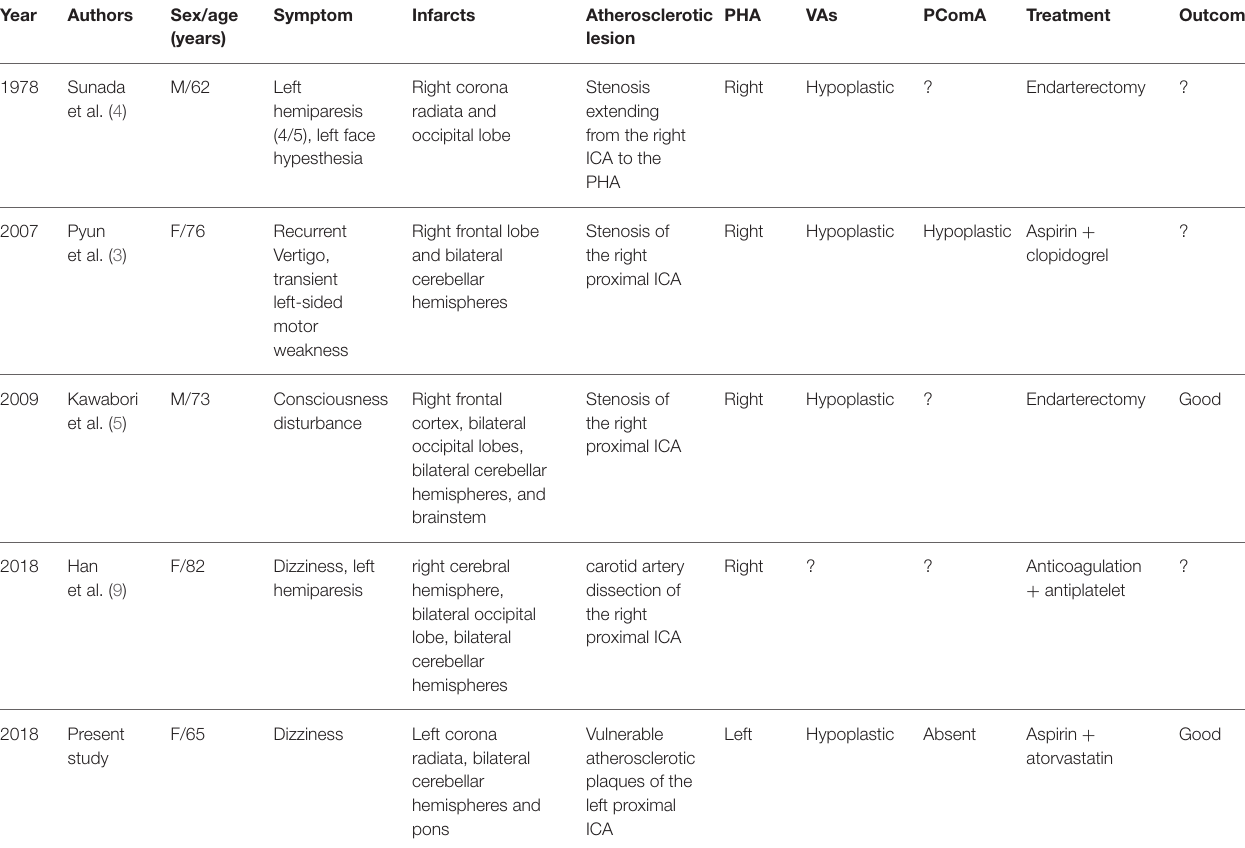
TABLE 1 | Reported cases with simultaneous carotid and vertebrobasilar infarctions related to PHA and carotid atherosclerotic